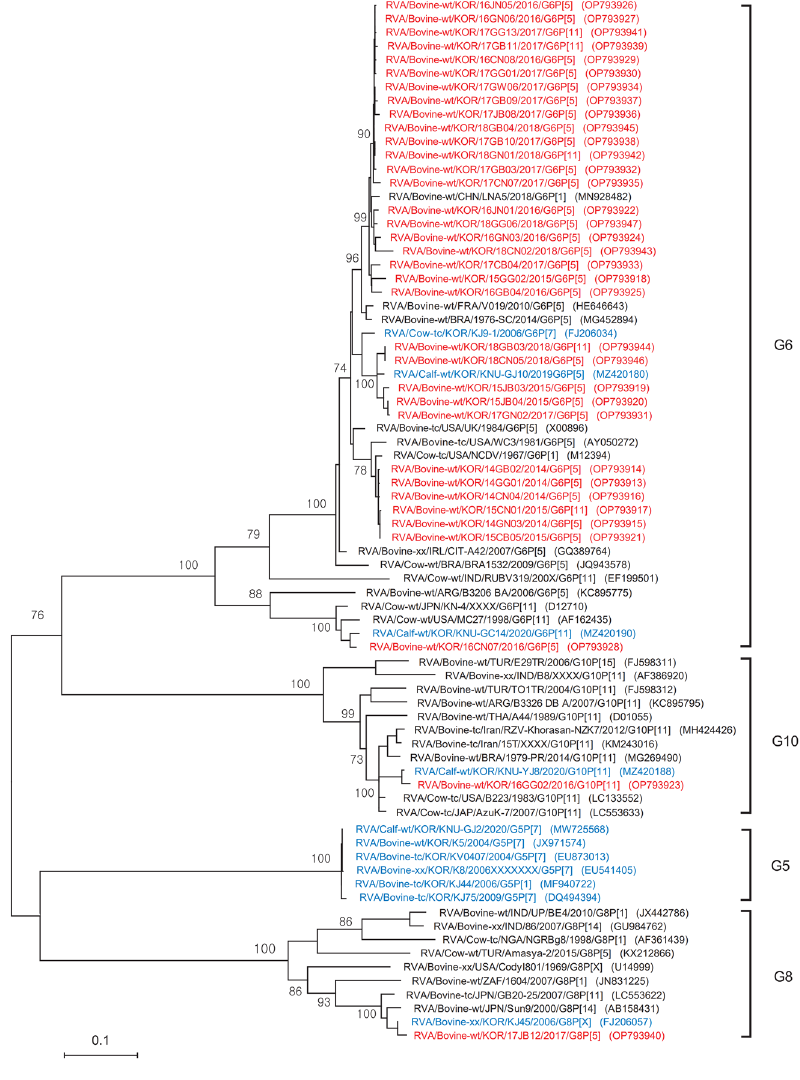
Figure 2. Phylogenetic analysis of a partial nucleotide sequence of the VP7 gene from 35 BoRVA antigen-positive samples and selected reference strains. The phylogenetic tree was constructed using the maximum-likelihood method (based on the Tamura 3-parameter model) in the MEGA X program and tested using 1000 bootstrap values. The 35 Korean BoRVA isolates identified in this study are highlighted in red and Korean BoRVA strains reported by previous studies are highlighted in blue.